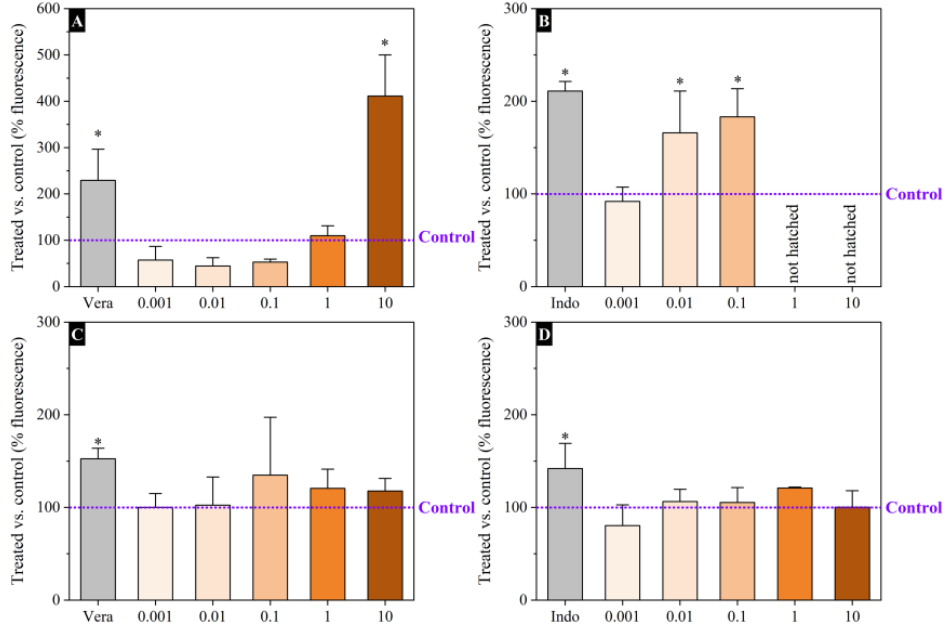
Figure 5. Inhibition of efflux transporters by nanoplastics. ( A ) Rhodamine accumulation in fish tissues together with verapamil (P-gp efflux inhibitor) and PS nanoplastics exposure for 1 day. ( B ) The hydrolytic metabolite of FDA accumulation in fish tissues together with indomethacin (MRP efflux inhibitor) and PS nanoplastics exposure for 1 day. ( C ) Rhodamine accumulation in fish tissues after removal of verapamil or PS nanoplastics exposure for 2 h. ( D ) The hydrolytic metabolite of FDA accumulation in fish tissues after removal of indomethacin and PS nanoplastics exposure for 2 h. FDA: fluorescein diacetate; P-gp: P-glycoprotein; MRP: multi-resistant protein; Vera: verapamil; Indo: indomethacin. Verapamil and indomethacin are used as positive inhibitor controls for P-gp and MRP transporters, respectively. * Indicates a significant difference compared to the control group ( p < 0.05).